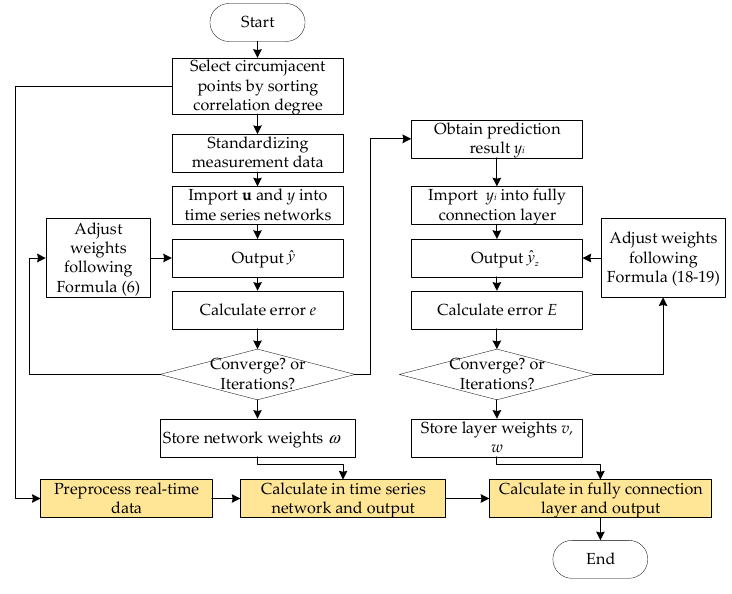
Figure 4. The spatio-temporal prediction algorithm flow.